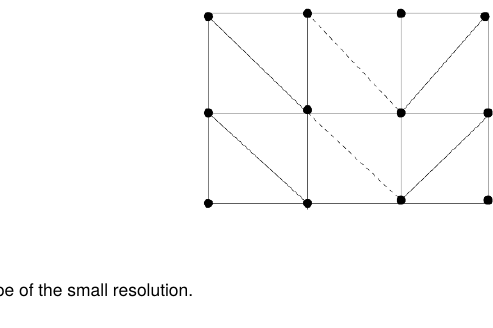
Figure 4. The Newton polytope of the small